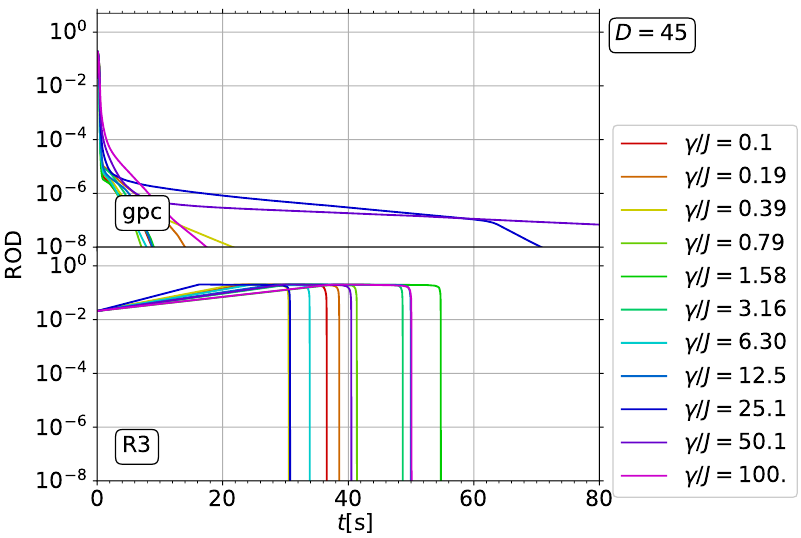
Figure 10: Exemplary ROD flow of the disordered dissipative scattering model, de- fined in (72), for N = 45 and W = J , calculated with the gpc-generator and R3- generator, averaged over 10